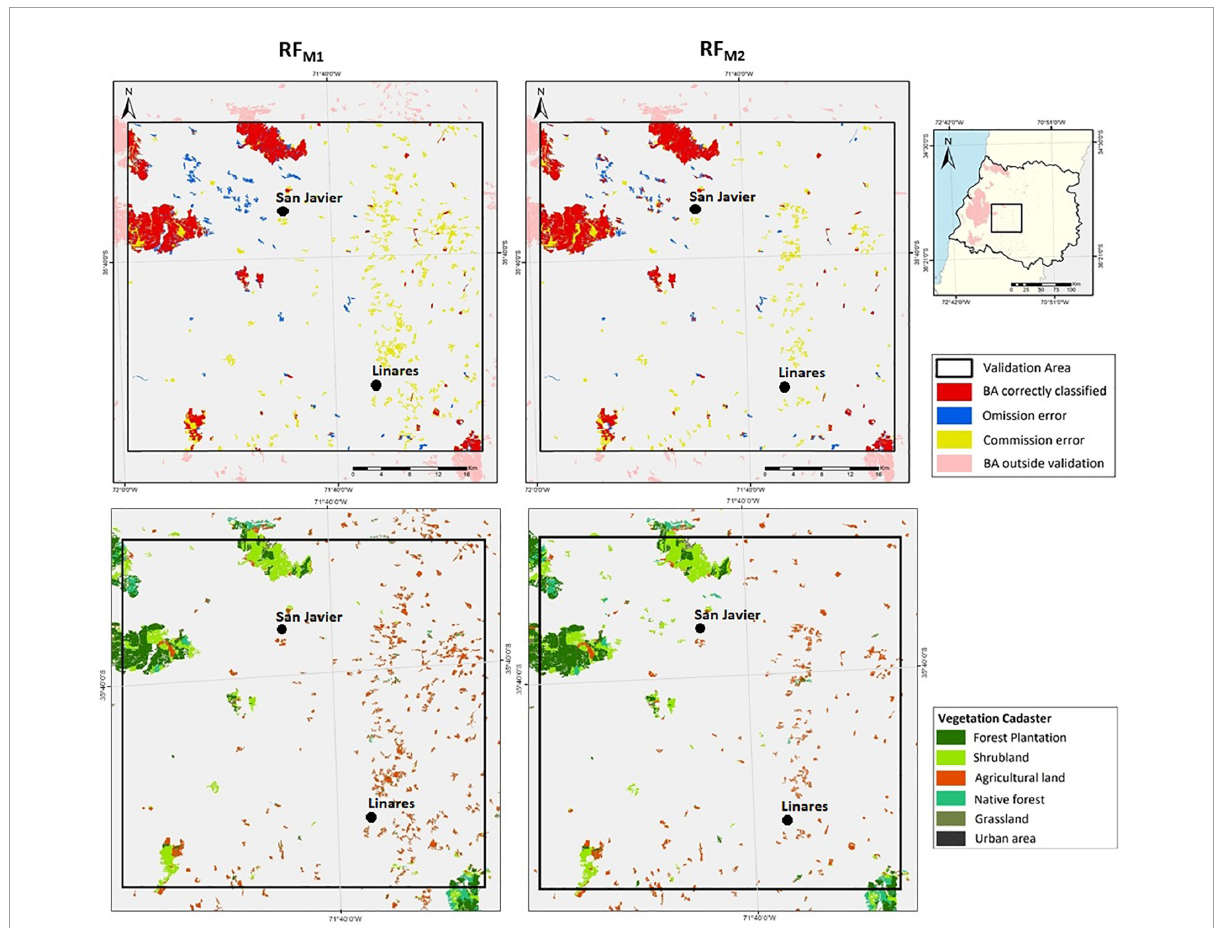
FIGURE7 On the top, evaluation of the omission and commission errors produced by the two burned area classification algorithms. On the bottom, land covers classified as burned areas by the two burned area classification algorithms are